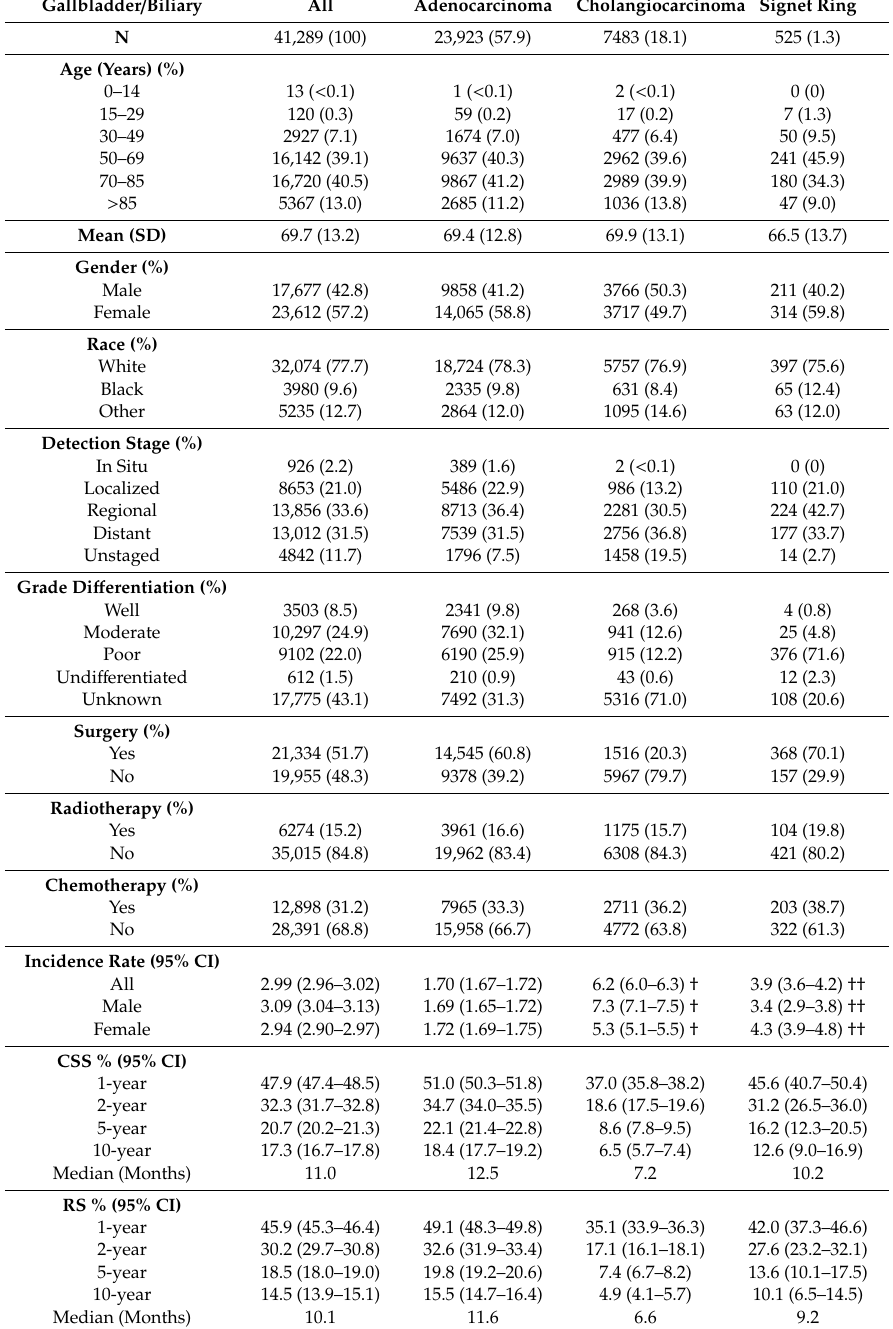
Table 15. Baseline demographics and clinical characteristics by histology for gallbladder / biliary cancers. Gallbladder / Biliary All Adenocarcinoma Cholangiocarcinoma Signet Ring N 41,289 (100) 23,923 (57.9) 7483 (18.1) 525